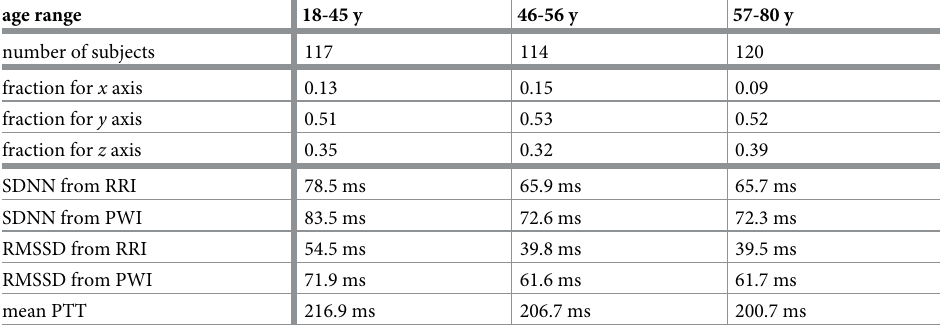
Table 3. Age dependence of SDNN and RMSSD and origin of matched PWI. For three similarly sized age groups the fractions of matched PWI derived from each of the three accelerometer axes are reported, showing the y axis data is used for more than half of all PWI correctly associated with RRI. The mean values of the HRV parameters SDNN and RMSSD and the mean PTT as derived from matched RRI and PWI are shown for comparison with literature [35, 39]. Regarding SDNN and RMSSD, all differences between the young age group and the other two groups are highly signifi- cant ( p � 0.002), while no significant differences occur between the intermediate and the elderly group. The results indicate that the reduction in SDNN and RMSSD with age is similar in RRI (as derived from the ECG) and PWI (as reconstructed through wrist actigraphy). The differences between the mean PPT values of the young group and the other two groups are weak but still highly significant ( p = 0.004 and p < 0.001, respectively), but also not significant between the intermediate and the elderly